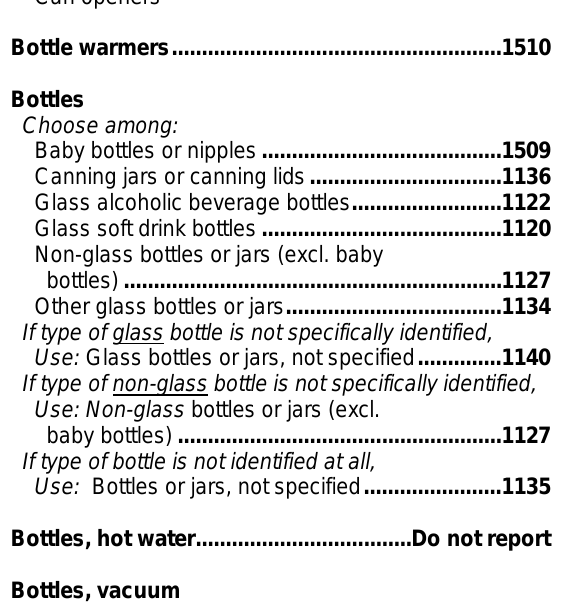
Bookstands Use: Tables (excl. baby changing tables, billiard or pool tables and television tables or stands) ... 4057